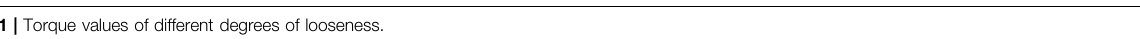
TABLE 1 | Torque values of different degrees of looseness.